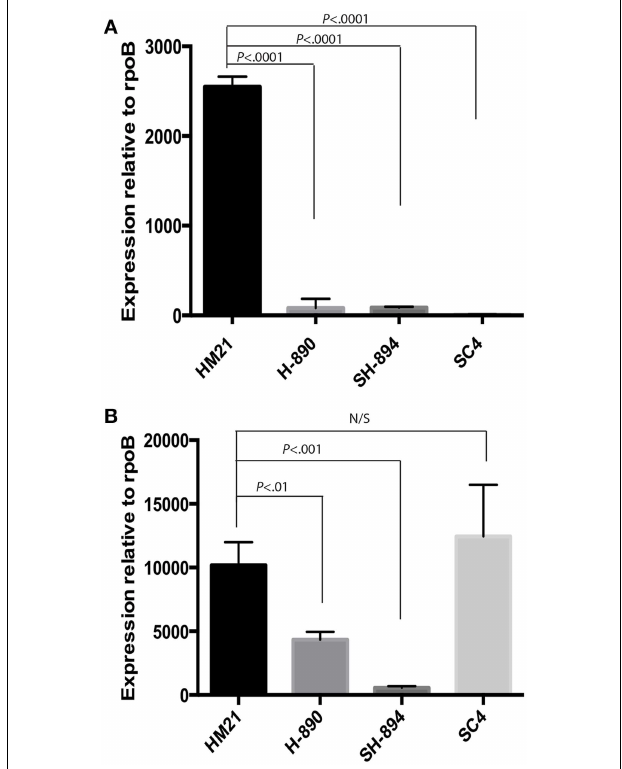
FIGURE 4 | QRT-PCR on hgpB mutants. Transcripts from cultures growth in an iron limiting medium with heme present was investigated for expression of hgpB (A) and hgpR (B) relative to rpoB . As expected the expression of hgpB is significantly lower in both hgpB mutants then HM21, indicating that the gene was successfully knocked out (A) . The expression of hgpR is significantly lower in both hgpB mutants when compared to HM21, revealing a possible polar mutation effecting transcription of hgpR (B) . Complementation with only hgpR (SHC4) did not restore expression of hgpB , providing further evidence for a polar mutation (A) . The statistically significant difference was determined using P < 0 . 05 Mann–Whitney test. Bonferroni corrections were preformed and the critical threshold is 0.016. Relative expression was calculated using the 2 − 1 Ct